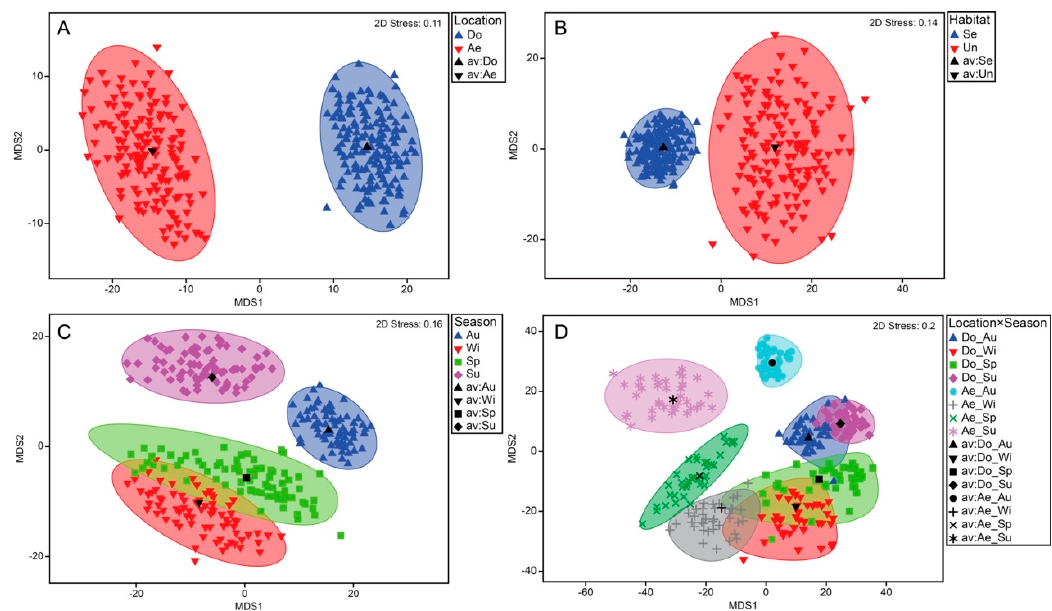
Figure 3. Metric multidimensional scaling (mMDS) for decapod assemblages from the two study locations ( A ), two habitat types ( B ), four seasons ( C ), and eight locations at each season ( D ); Do = Dongday Bay, Ae = Aenggagn Bay, Se = seagrass bed, Un = unvegetated habitat; Wi = winter, Sp = spring, Su = summer, Au = autumn.